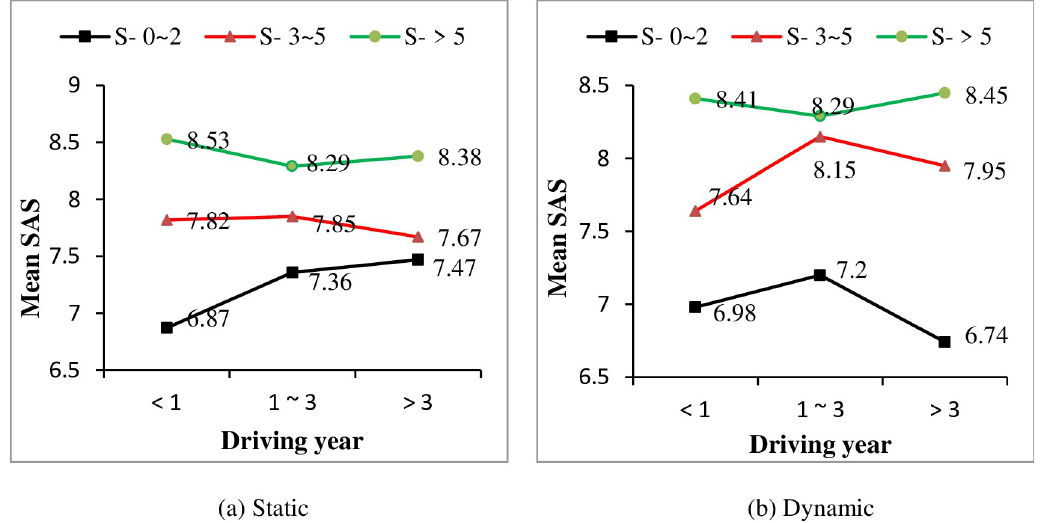
Fig 4. Effect of driving frequency on self-assessment score (SAS) under different driving year